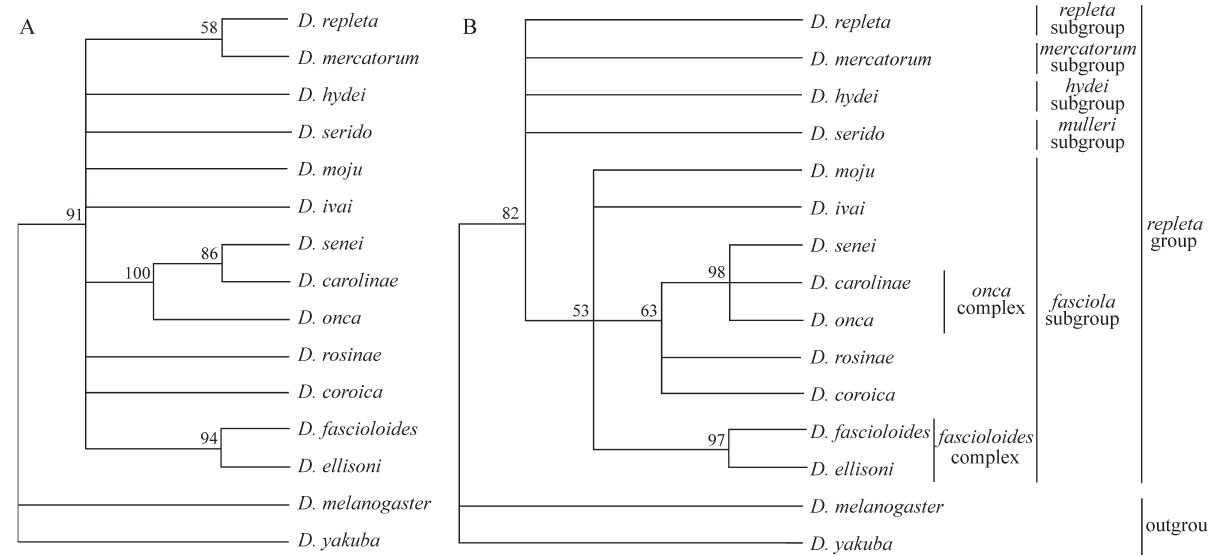
Figure 3 - Phylogenetic relationships among species of the repleta group and the fasciola subgroup inferred from partial sequences of the mitochondrial cytochromeoxidasesubunitI( COI )gene,baseduponMPanalysis.Bootstrapvaluesfor1,000replicates aregivenatthenodes.A)Equalweightingofall informative characters. B) Transitions were excluded and third codon positions assigned weights 0.5.